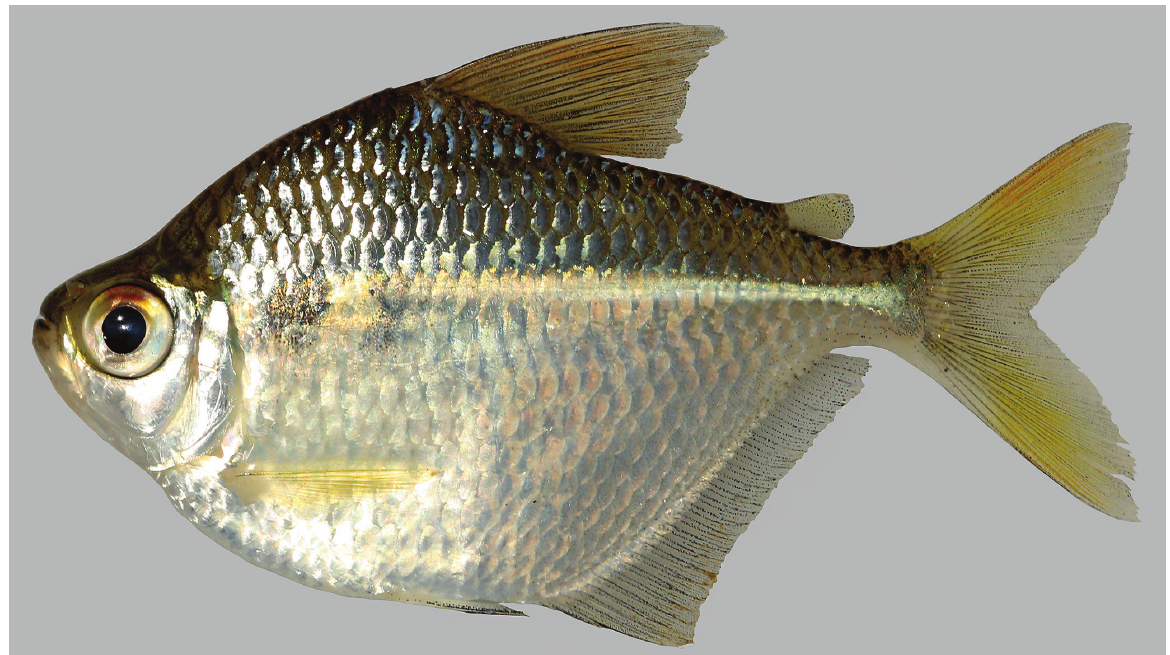
Fig. 4. Poptella actenolepis , MZUSP 122982, paratype, 55.1 mm SL, Brazil, Amazonas, Apuí, Rio Juma, Rio Madeira basin. Photo by W. Ohara.